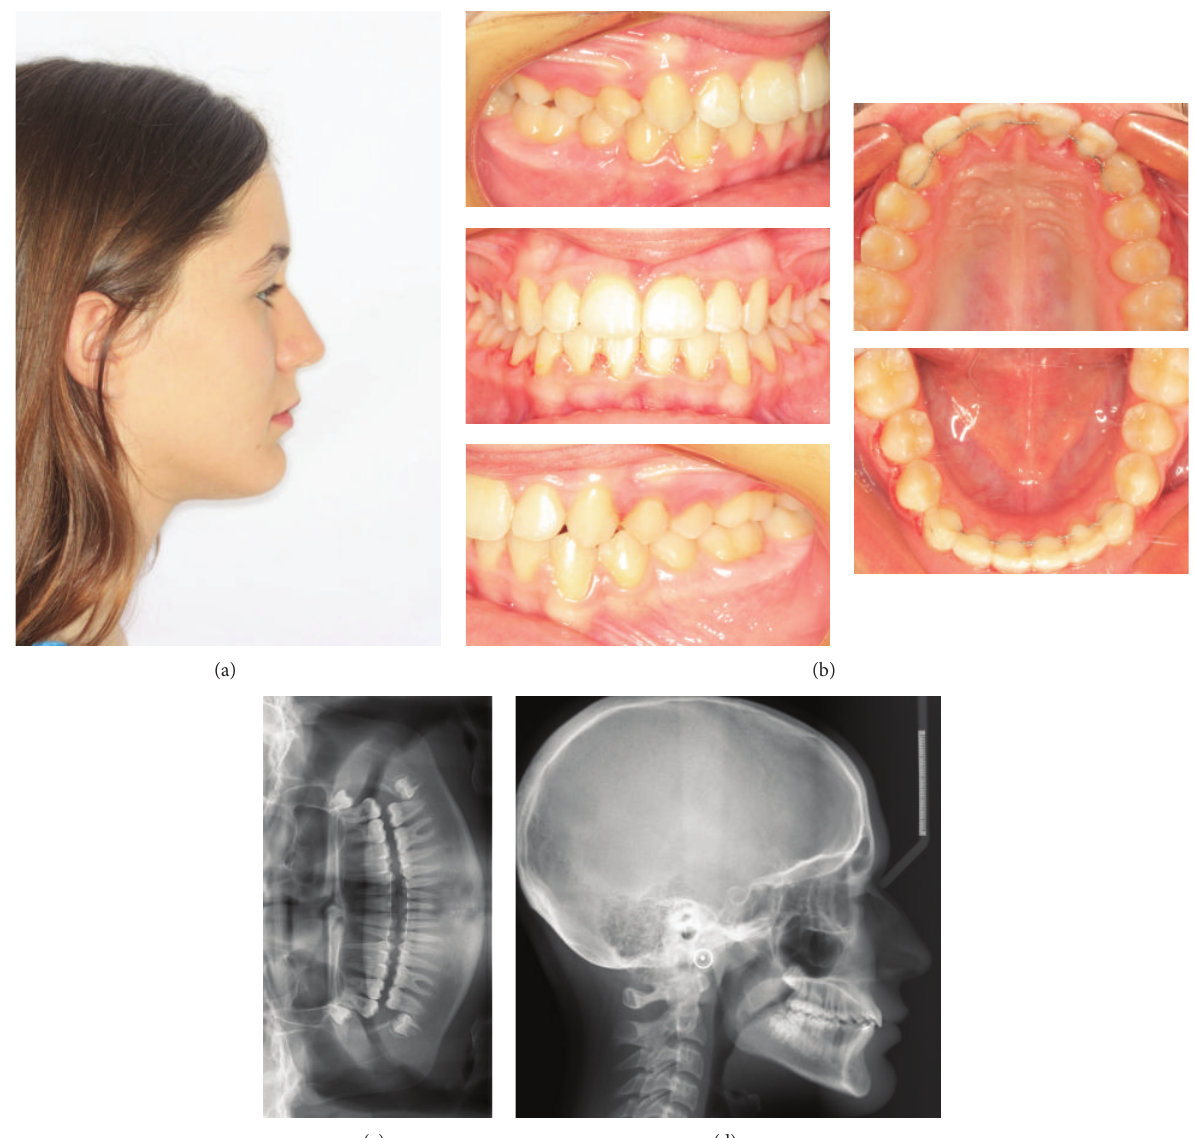
Figure 6: Posttreatment records: (a) extraoral profile photo, (b) dental casts, (c) panoramic radiograph, and (d) cephalometric